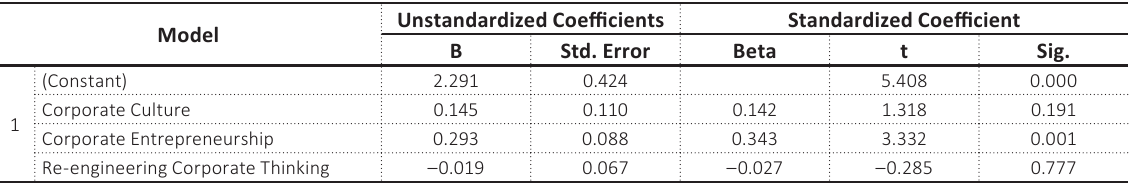
Table 13. Regressing intrapreneurship sub- variables on diversification